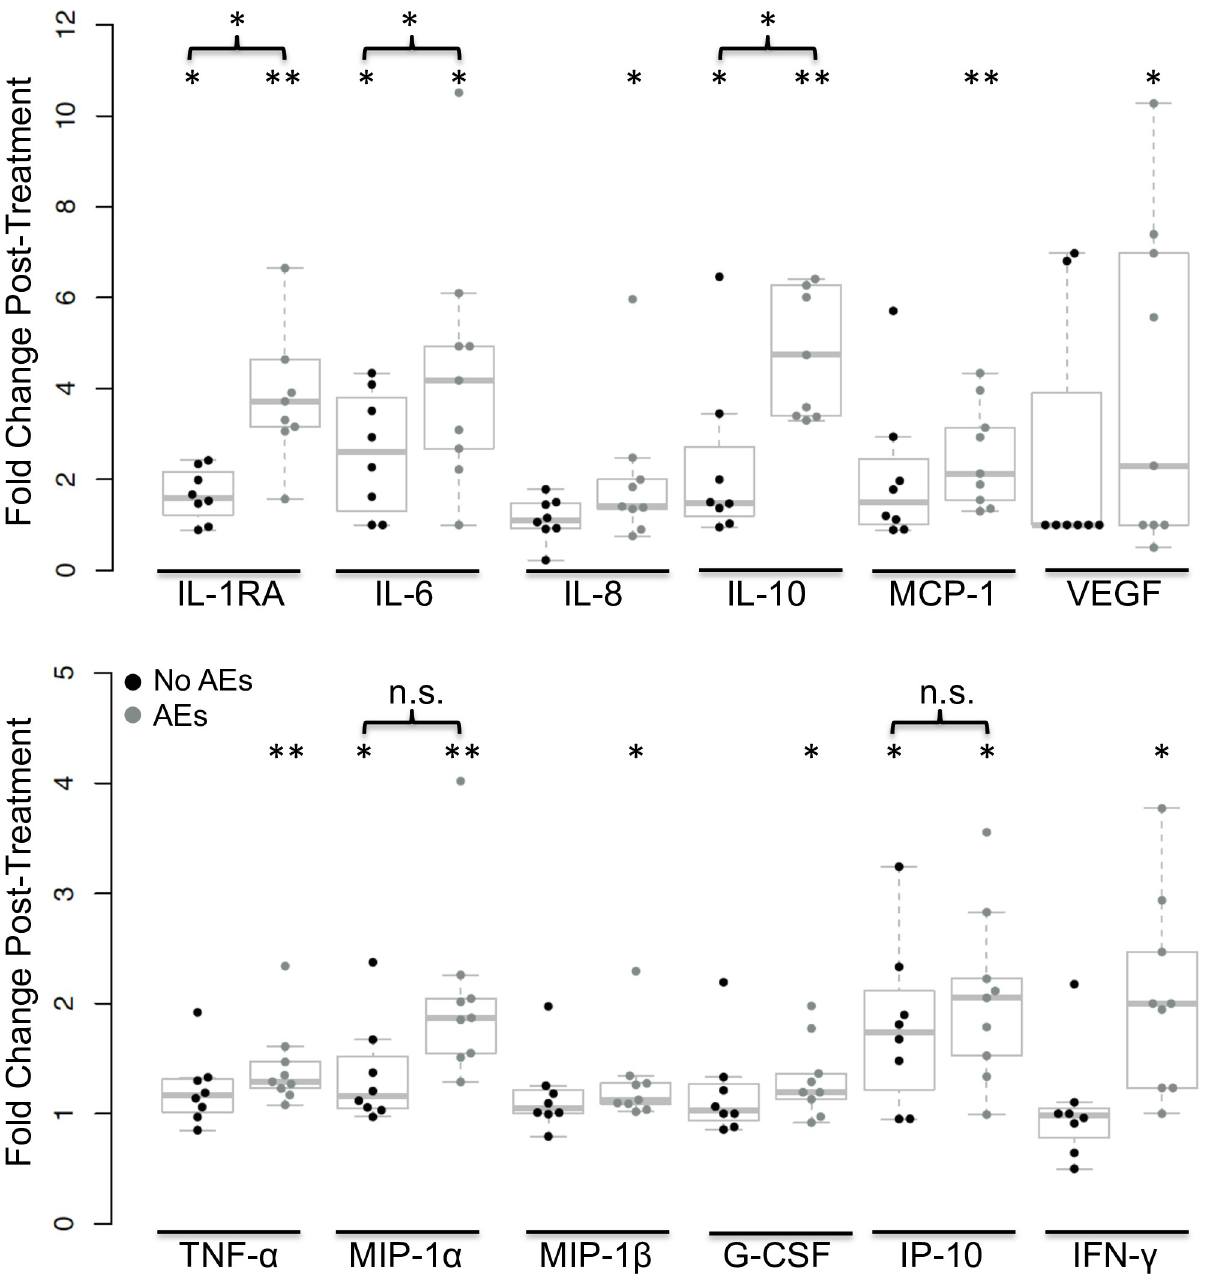
Fig 3. Post-treatment fold changes for 12 cytokines in nine participants who experienced moderate AEs and in nine participants who had no AEs. Levels of IL-8, MCP-1, VEGF, TNF- α , MIP-1 β , G-CSF and IFN- γ significantly increased post-treatment in individuals with moderate AEs, and levels of IL-1RA, IL-6, IL-10, MIP-1 α and IP-10 increased significantly post-treatment in individuals with moderate AEs and in individuals with no AEs ( � P < 0.05, �� P < 0.001 by Wilcoxon signed-rank tests). IL-1RA, IL-6 and IL-10 increased more in individuals with moderate AEs ( � P < 0.05 by Mann-Whitney U